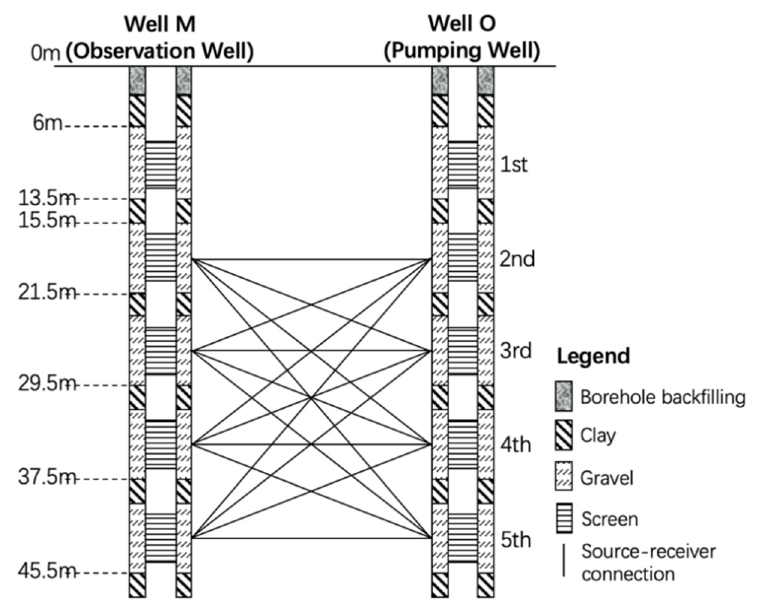
Figure 6. Illustration of the tomographical multi-level pumping test setup.